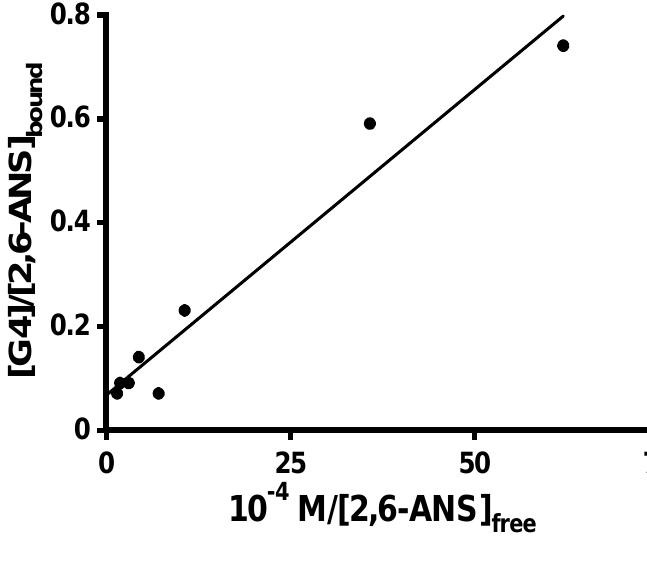
Figure 8. The double-reciprocal plot from the guest titration data for 4 × 10 -5 M 2,6-ANS in the presence of 0.0025 mM G4 PAMAM dendrimer; the solid line shows the linear